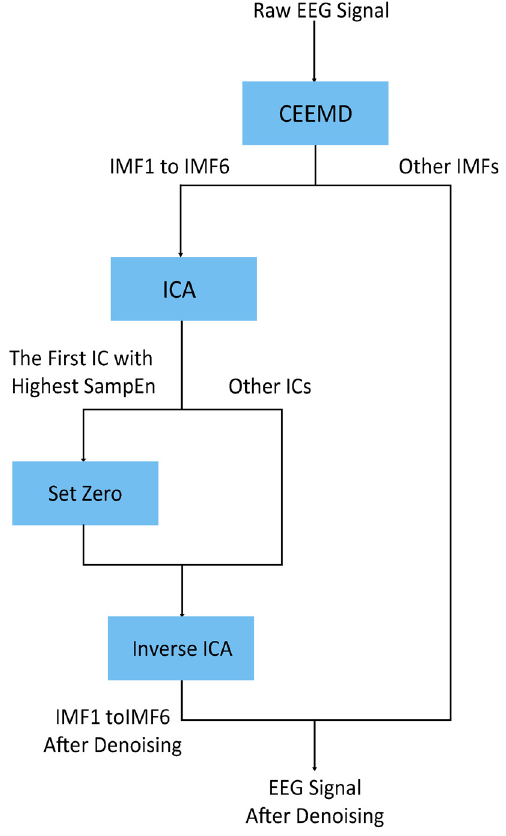
Figure 3. Signal Preprocessing Process.